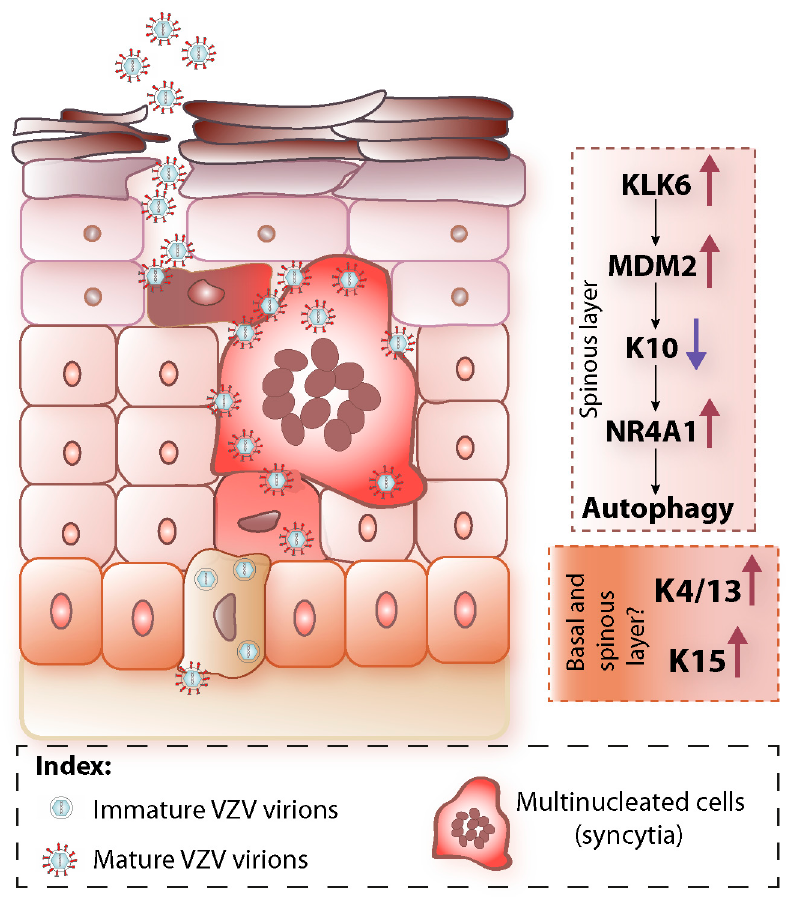
Figure 2. Schematic of VZV interplay with epidermal terminal differentiation. Left model of VZV- infected epidermis: VZV infects epidermal basal keratinocytes where starts to replicate. The newly formed virions in the basal keratinocytes are immature and do not express glycoproteins. In the suprabasal layers VZV virions mature together with epidermal differentiation and express glyco- proteins. They also spread cell-to-cell via syncytia formation. At the uppermost epidermal layers mature and cell-free virions are released. Right panel: summary of the major changes induced by VZV to epidermal host pathways. They include in the spinous layer the downregulation of keratin K10 due to its degradation and caused by MDM2, which is upregulated by increased levels of KLK6. K10 downregulation has a structural effect on blister and syncytia formation, but also a signalling effect by upregulating NR4A1, which in turn induces activation of autophagy pathways. Keratin K15, which is normally expressed in the basal layer, is upregulated and its expression is found also in differentiated keratinocytes. K4 and K13 are also upregulated in differentiated keratinocytes during VZV infection.